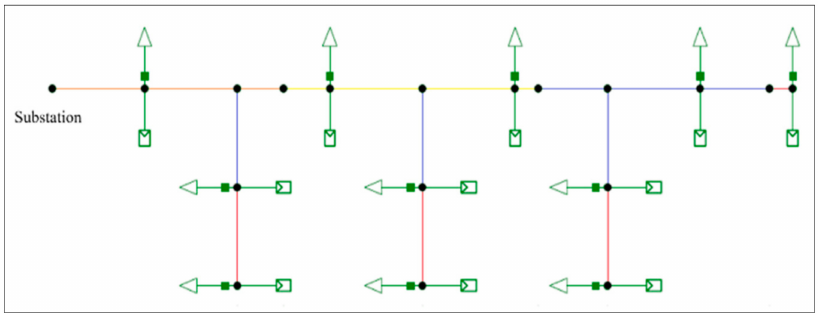
Figure 4. Distribution feeder considered for both 13.2 and 8.32 kV